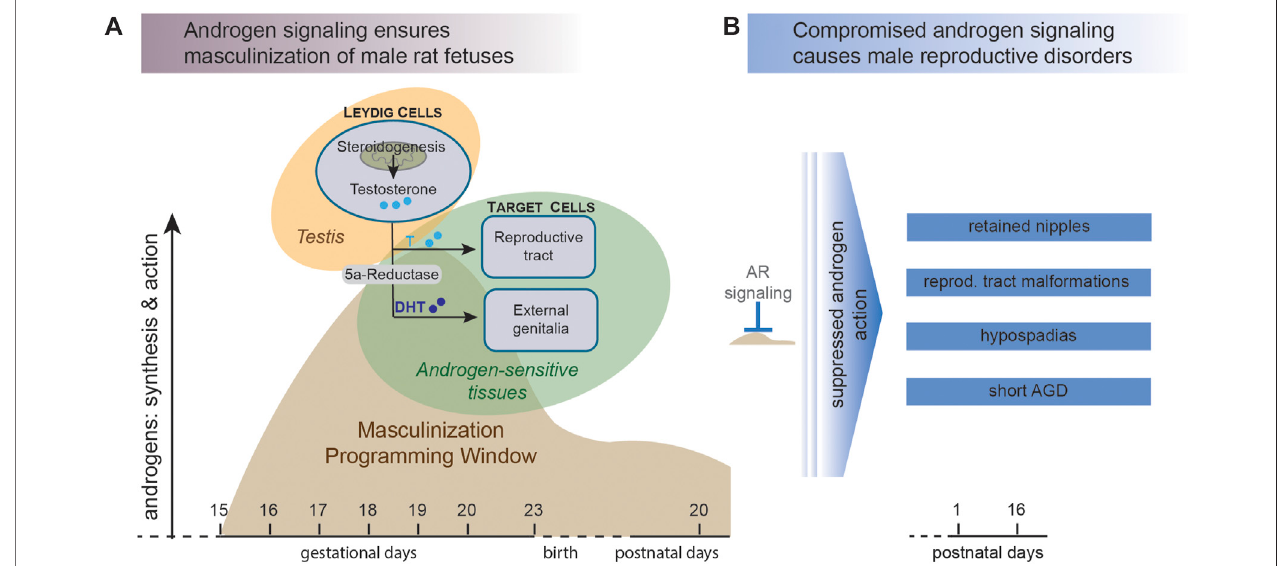
FIGURE1| Disruptedandrogenactionduringthemalemasculinizationprogrammingwindow(MPW)canleadtoreproductivedisordersinmaleoffspring. (A) Inmammals, themalefetusisacquiringmalecharacteristicsinresponsetoandrogensignaling.TestosteroneissynthesizedbyLeydigcellsinthefetaltestisandthenexcretedintothecirculation. Here,testosteronecanbeconvertedtothemorepotentliganddihydrotestosterone(DHT),whichactivatesandrogenreceptor(AR)incellsofthepresumptiveexternalgenitaliaand prompts differentiation into male reproductive tissues. The main masculinization events take place during a speci fi c stage of fetal life denoted the masculinization programming window (MPW), which in rats is around days 15 – 19 of gestation (adapted from (Welsh et al., 2008). (B) Failure to initiate the masculinization differentiation events during the MPW, for instance by exposure to anti-androgenic chemicals, can lead to undervirilization of the male offspring and various reproductive disorders.